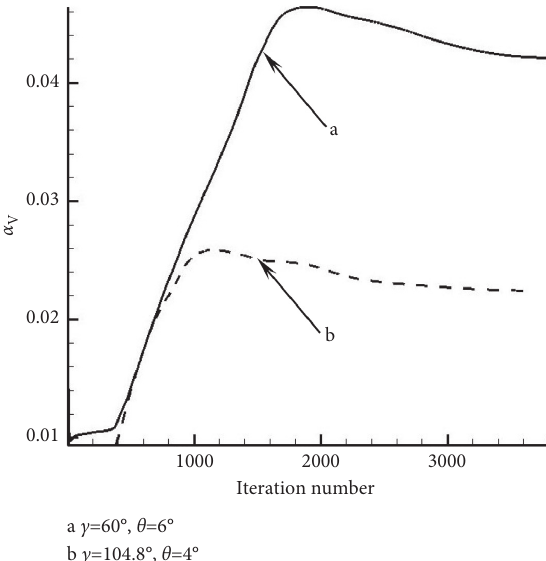
Figure 12: α v change diagram of the two kinds of triangular throttling grooves and their kidney shape hole fluid when piston crosses over the bottom dead